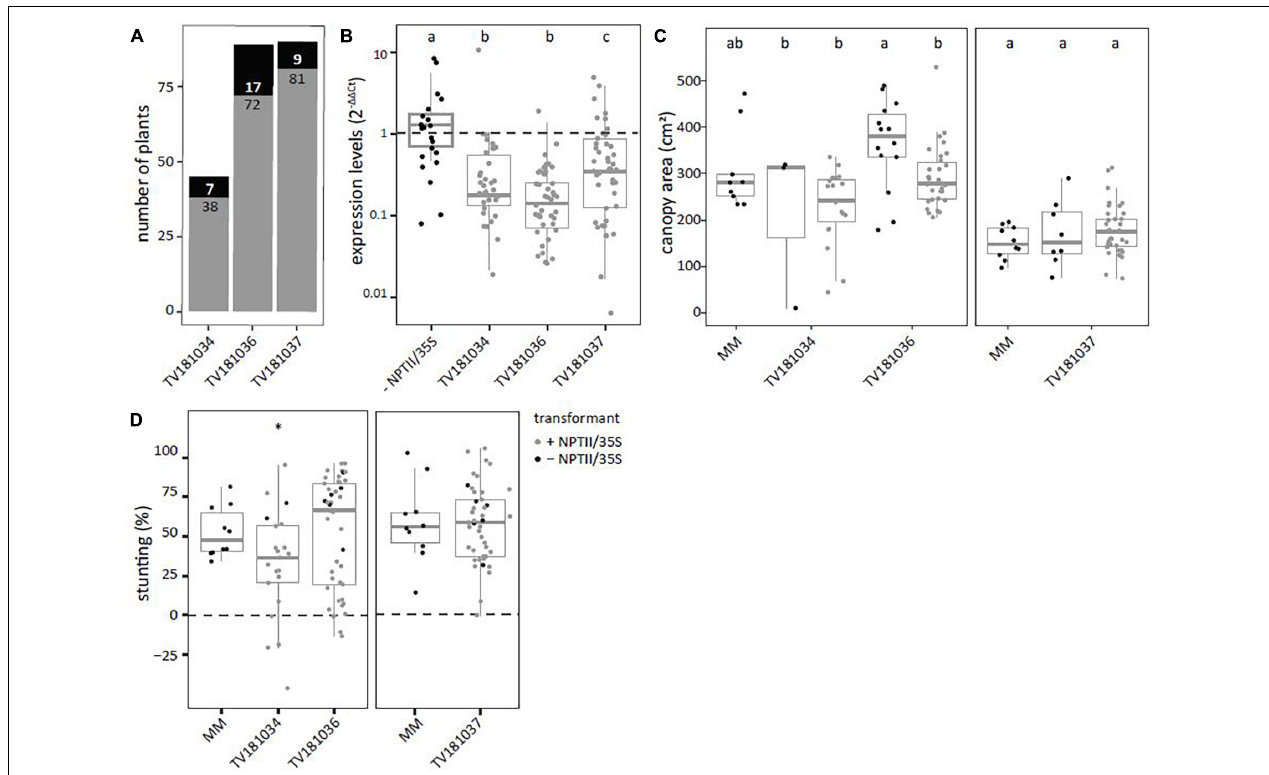
FIGURE 2 | Reduced susceptibility to V. dahliae was found in SlWAT1 T2 RNAi family TV181034, but not for TV181036 and TV181037. (A) Total number of plants with (gray) and without (black) the silencing construct for each of the obtained T2 RNAi families. (B) Expression levels of SlWAT1 in roots collected at 21 dpi of plants with the silencing construct (+ NPTII/35S, gray dots) relatively to plants without the silencing construct (– NPTII/35S, black dots) for all families. Data were normalized using 2 − (cid:49)(cid:49) Ct to SlEF1 α with n ≥ 4 per family (ANOVA with Fisher’s unprotected LSD with p = 0.05 on (cid:49) Ct values). (C) Canopy area (cm 2 ) of mock-inoculated plants at 21 dpi for T2 RNAi families with (gray) and without (black) the silencing construct ( n ≥ 3, ANOVA with Fisher’s unprotected LSD, p = 0.05). (D) Stunting of V. dahliae- inoculated plants when compared with the average stunting of mock-inoculated plants per genotype at 21 dpi ( n ≥ 5, t -test with ∗ p < 0.05). a–c: Genotypes having average values with a letter in common are not statistically significant different (at P =